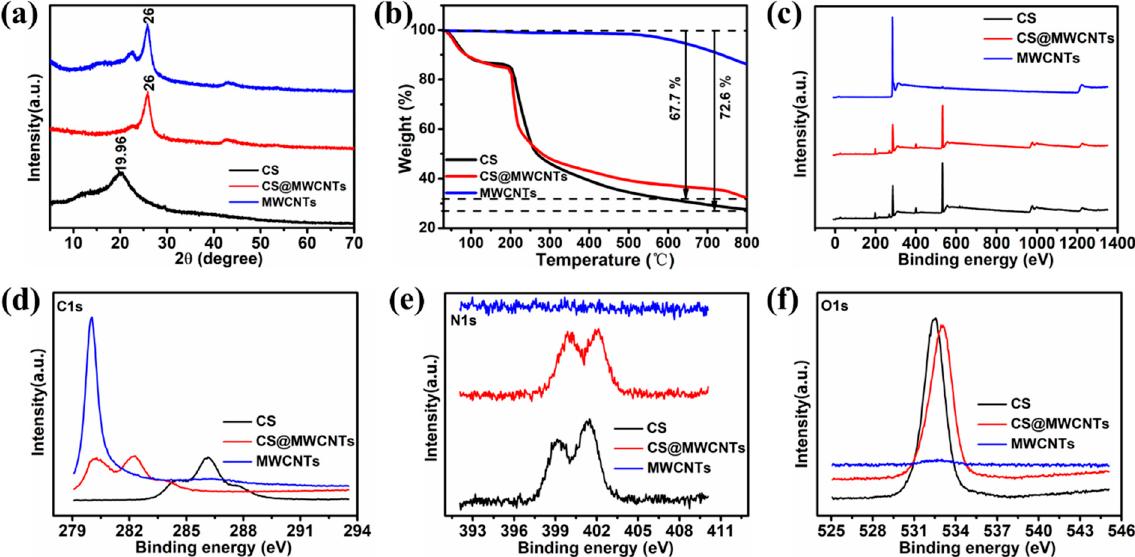
Figure 2. ( a ) XRD patterns of CS, MWCNTs, and CS@MWCNTs; ( b ) TGA curves in nitrogen atmosphere of CS, MWCNTs, and CS@MWCNTs; ( c ) XPS wide scan spectra of CS, MWCNTs, and CS@MWCNTs and corresponding high-resolution spectra of ( d ) C 1 s, ( e ) N 1 s, ( f ) O 1 s,